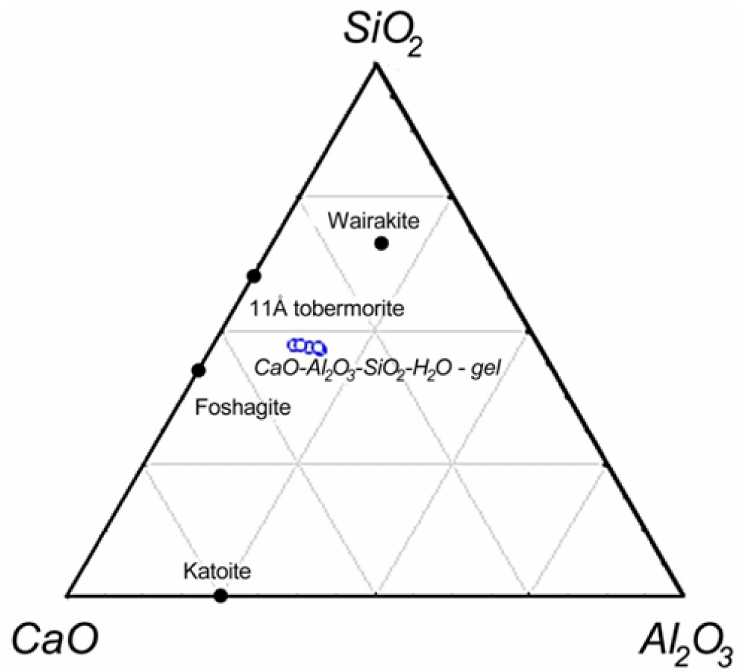
Figure 12. System of CaO–Al 2 O 3 –SiO 2 –H 2 O gel and newly-formed phases synthesized in “quicklime– GMM” system under autoclave